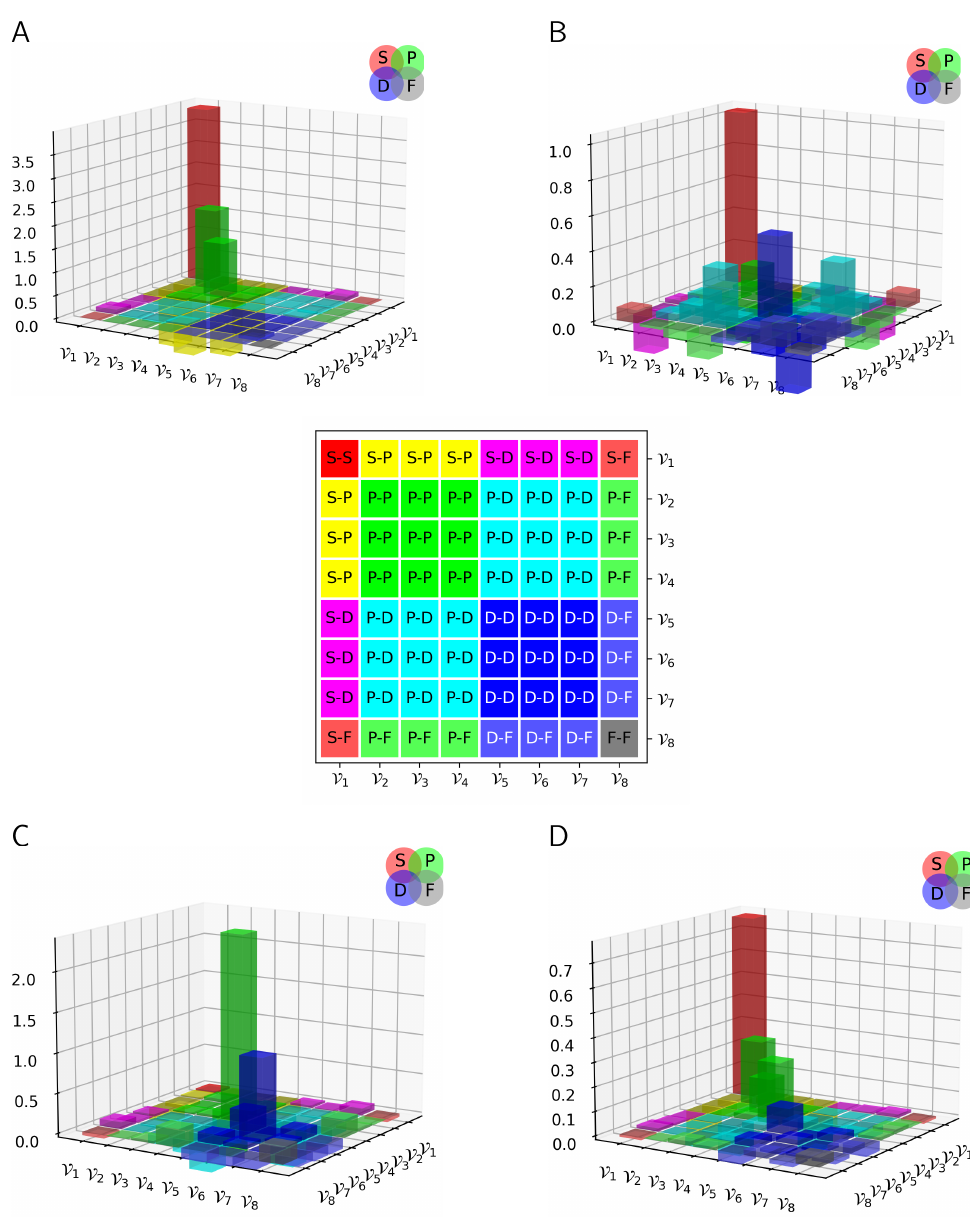
Figure 11. Rest-frame quark+axial vector–diquark orbital angular momentum content of ( 3 baryons considered in Reference[267], as measured by the contribution from the various components to the associated canonical normalisation constant: A ∆ ( 1232 ) 3 − ∆ ( 1940 ) 3 . The overall positive normalisations receive both positive (above plane) and negative 2 (below plane) contributions. The central image provides the legend for the interpretation of the other panels, identifying interference between the various identified orbital angular momentum basis components in the baryon